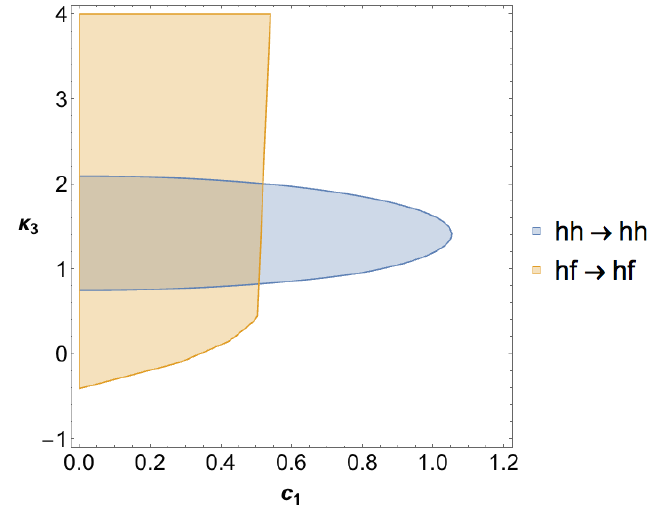
Figure 4 . Comparison of the allowed region of cubic parameters c 1 ; (cid:20) 3 obtained from the inde(cid:12)nite hh ! hh and hf ! hf scatterings, for x = m 1 =m 2 = 1, c 2 = c 1 , and vanishing quartic couplings (cid:21) = (cid:20) 4 = 0, (cid:13) = 1. Each channel allows the removal of a di(cid:11)erent region of parameter